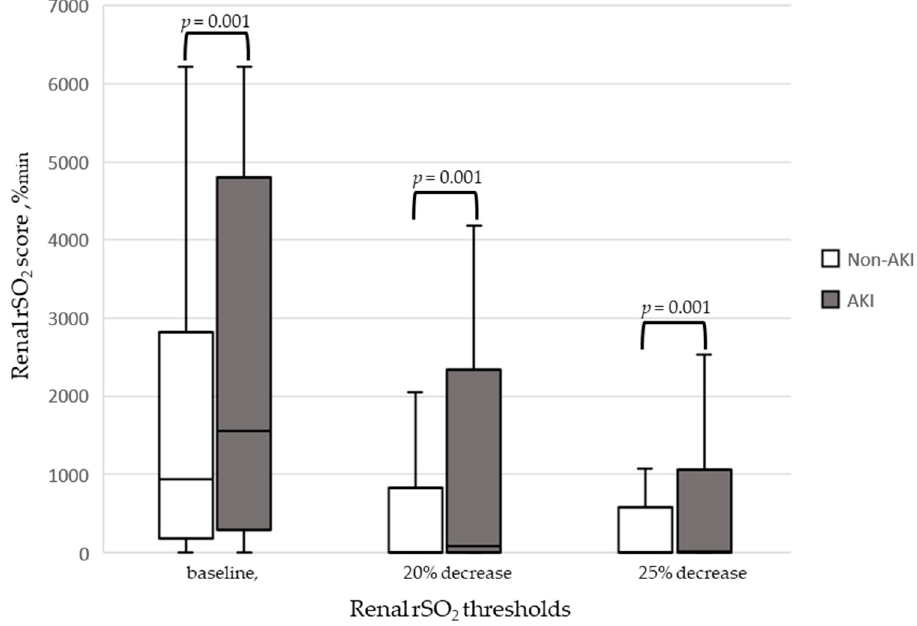
Figure 2. Comparison of cumulative saturation of rSO 2 at baseline, 20% decrease, and 25% decrease. The median renal rSO 2 score during CPB was 943.0% min in the non-AKI group versus 1637.5% min in the AKI group. The median score at a 20% decrease was 8.0% min for the non-AKI group and 85.5% min for the AKI group, and at a 25% decrease, the median score was 1.0% min for the non-AKI group and 32.5% min for the AKI group. A significant correlation was observed in both cases ( p < 0.001).